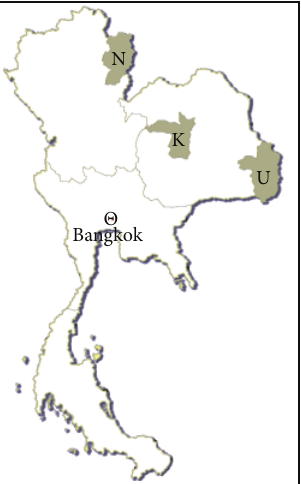
Figure 1: Map of Thailand showing study areas. N, Nan; U, Ubon Ratchathani; K, Khon